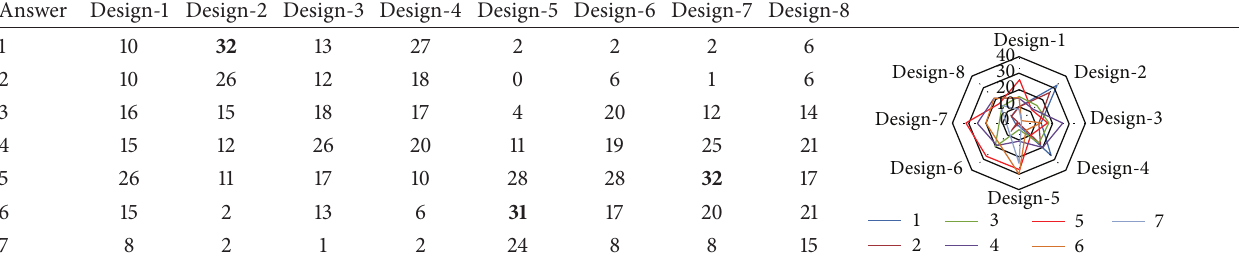
Table 2: Kansei frame design preference results (based on dislike versus like).